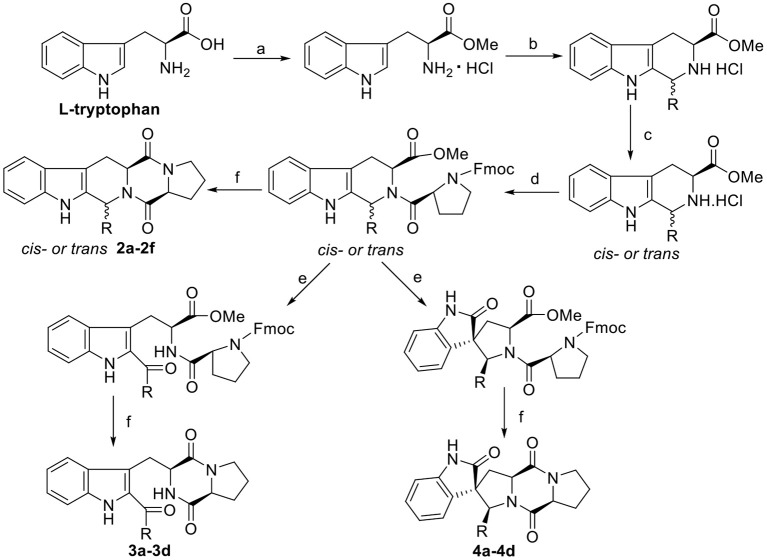
Synthesis route of the target compounds 2a−2f, 3a−3d, and 4a−4d. Reaction conditions: (a) SOCl2, CH3OH; (b) i-PrOH, R-CHO, reflux; (c) CH3NO2/toluene, CIAT; (d) Fmoc-L-Pro-Cl, TEA, DCM/Na2CO3(aq); (e) NBS, AcOH, THF-H2O (1:1); (f) morpholine, DCM.